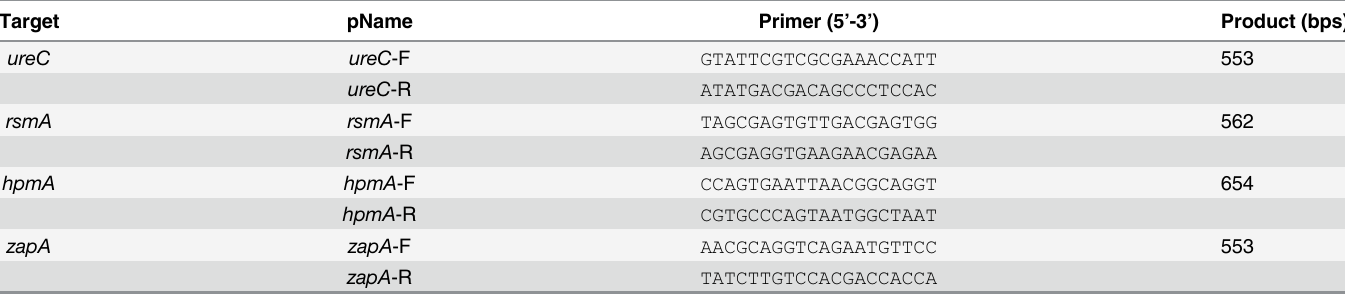
Table 1. PCR primers for the four